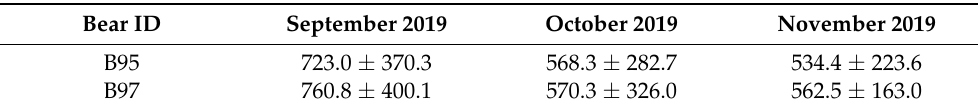
Table 2. Mean distance ± SD (m) between each GPS fix and closest settlement for the two bears B95 and B97 from September 2019 until November 2019.